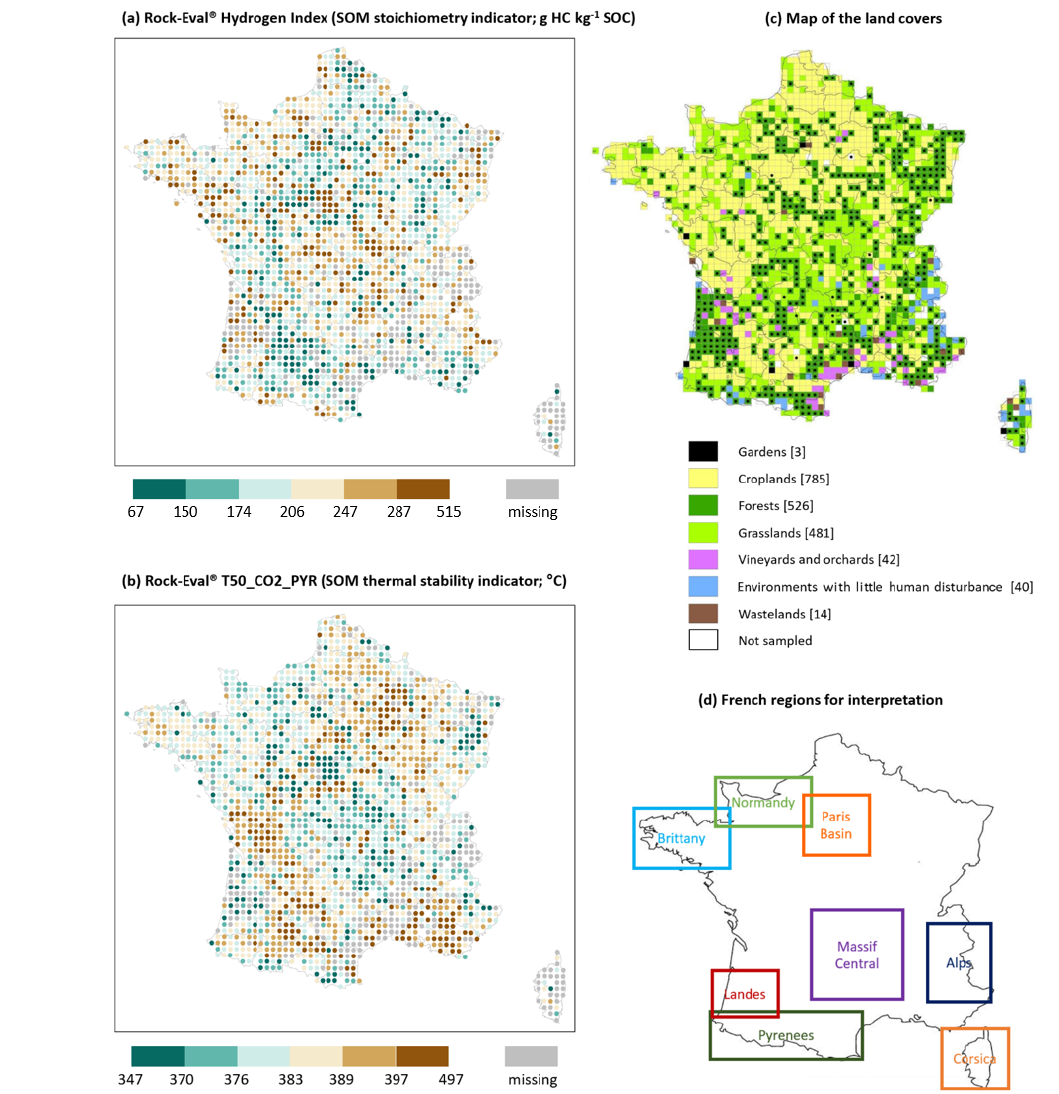
Figure 4. Point maps of two Rock-Eval ® parameters – (a) hydrogen index values and (b) T50_CO2_PYR values – on the French mainland territory for the RMQS topsoil (0–30cm) samples; (c) a map of the land cover at each sampling site (the numbers in square brackets correspond to the number of sites for each land cover in our final dataset; n = 1891), modified from Jolivet (2011); and (d) a map of the main regions used for the